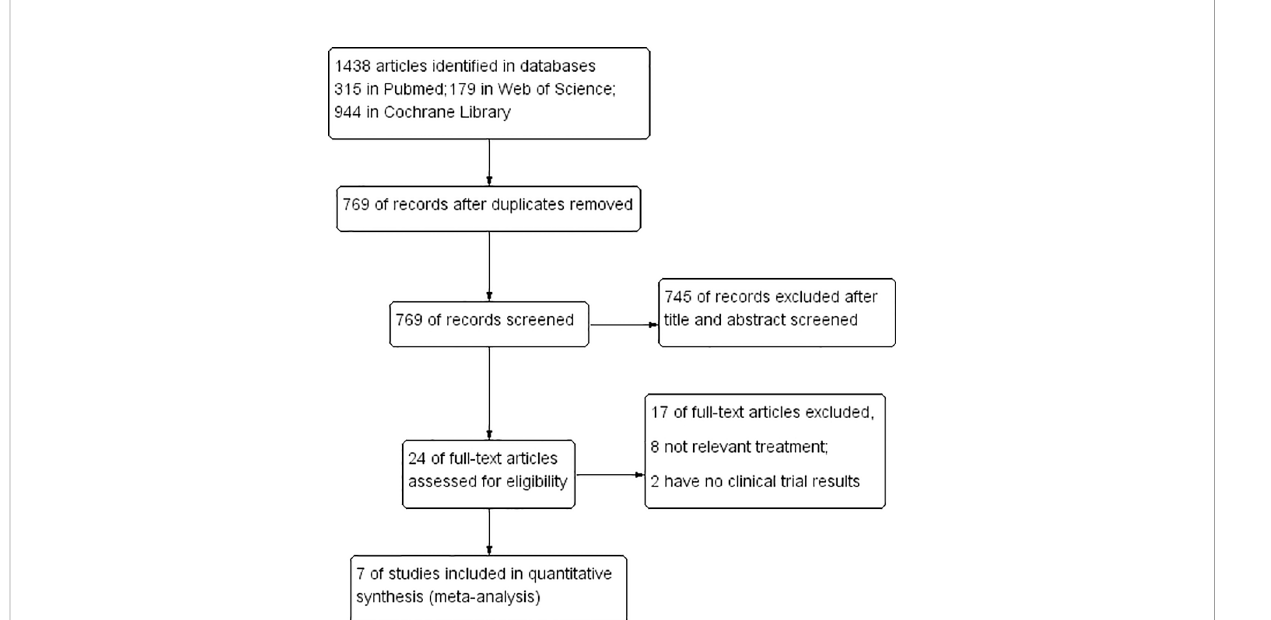
FIGURE 1 The Prisma search strategy fl owchart followed in article search and selection in this study. This systematic review includes 7 studies, including 3 randomized controlled trials and 6 single-arm